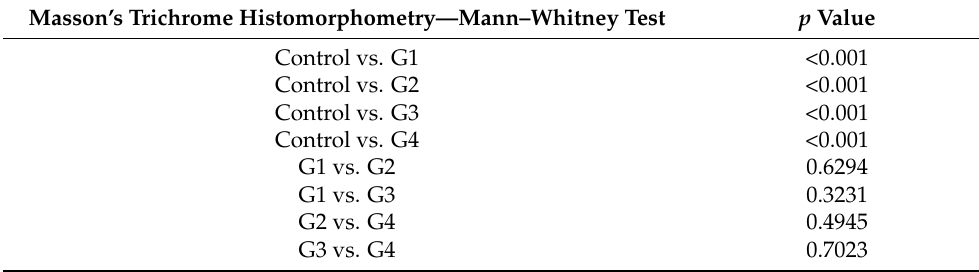
Table 1. Histomorphometric analysis—Masson’s trichrome using the Mann–Whitney statistical test with a significance level of 5% ( p ≤ 0.05).